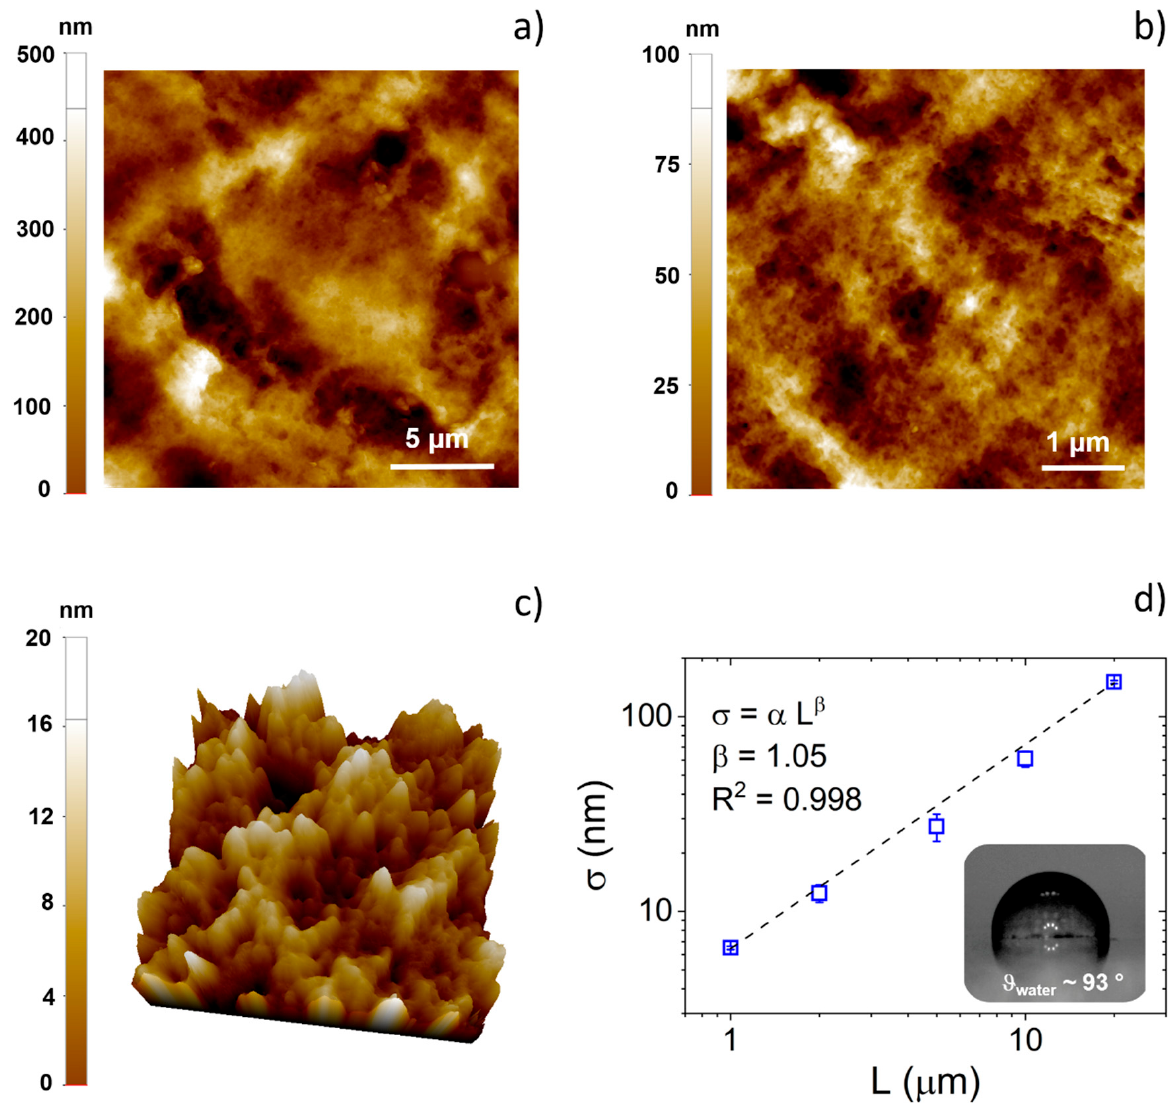
Figure 1. Surface characterization of PEDOT:Nafion coatings. Two-dimensional ( a , b ) and three-dimensional ( c ) topography images of PEDOT:Nafion coatings acquired at different scale lengths. The lateral scan size is 1 µ m in (c). ( d ) Plot of RMS ( σ ) vs. lateral scan size (L). The dashed dot size represents the best fit, according to the power law ( σ = α L β ). Inset of (d): a representative image of a water droplet on the PEDOT:Nafion coating.